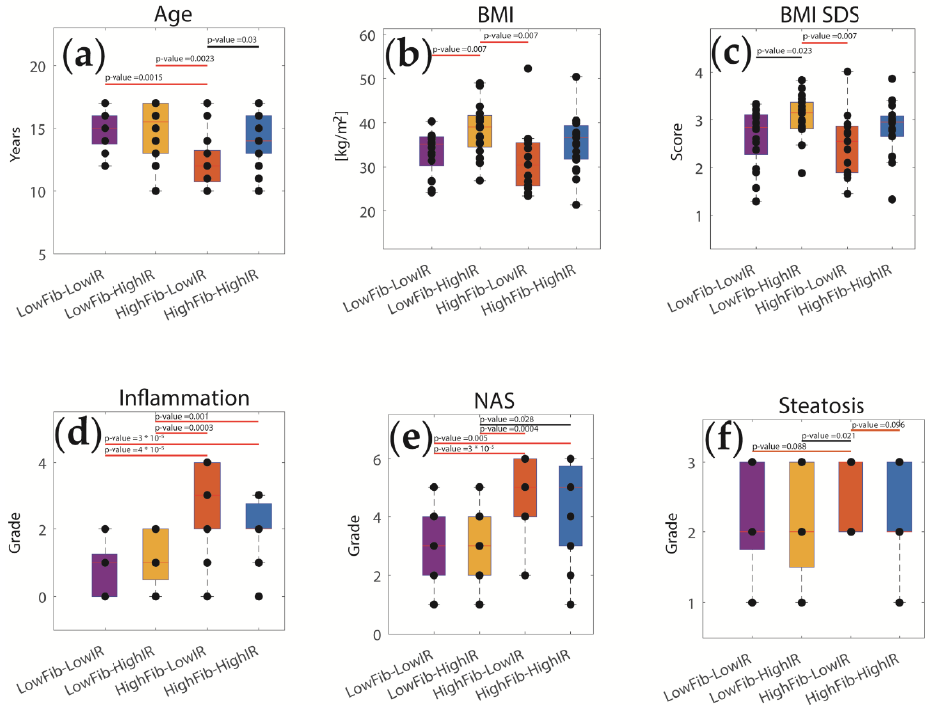
Figure 5. Clinical parameters of pediatric patients in four different disease classes (variant A). ( a ) Age; ( b ) BMI; ( c ) BMI Standard Deviation Score (SDS); ( d ) NAFLD Activity Score (NAS); ( e ) Inflammation score; ( f ) Degree of fibrosis. Crossbars indicate differences between groups based on two-sided t -testing (orange: p < 0.1; black: p < 0.05; red: p < 0.01). Corresponding p -values are given above bars.